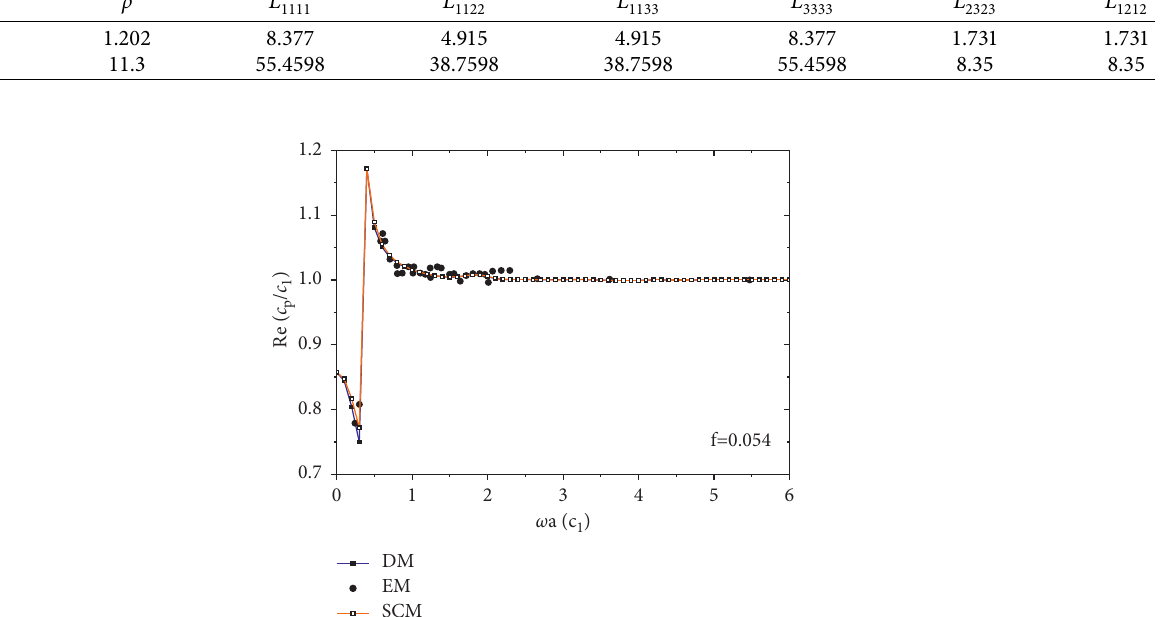
Table 1: Elastic modulus and density of the matrix and inclusion. The units of modulus and density are GPa and 10 3 Kg/m 3 , respectively. Materials ρ L